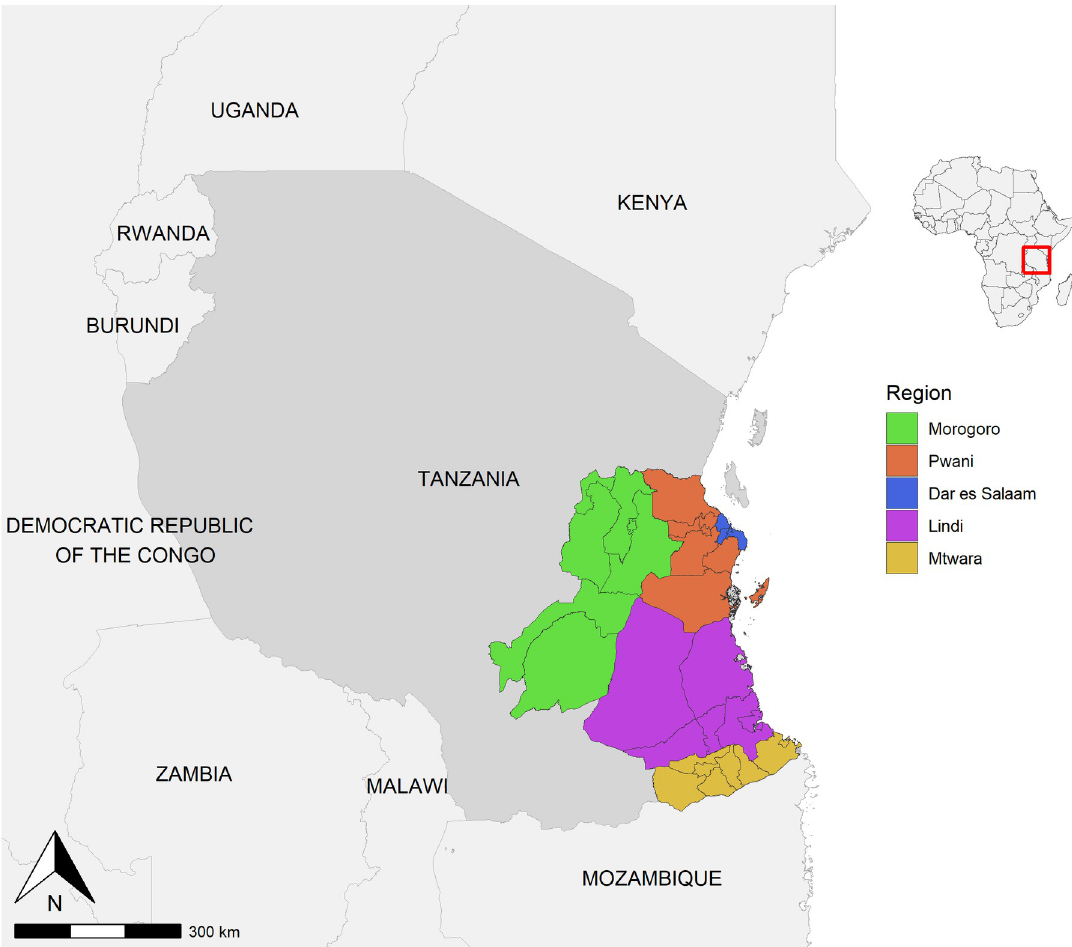
Fig 1. The study districts in south-east Tanzania where mass dog vaccinations and post-vaccination transects were undertaken. Shapefiles to make this figure were downloaded from the Diva GIS data portal (https://www.diva-gis.org/).